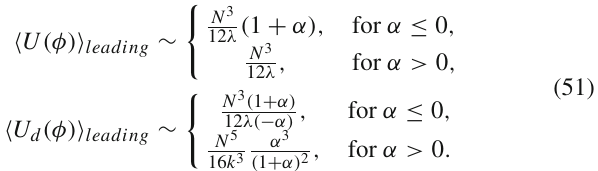
Fig. 2 The behavior of the observables with respect to α = ( R − R )/ R c c in the large N limit, based on the saddle point analysis with the use of the leading order result of f N , R . The parameters are assumed to be λ ∼ O ( 1 ) and k (cid:3) O ( 1